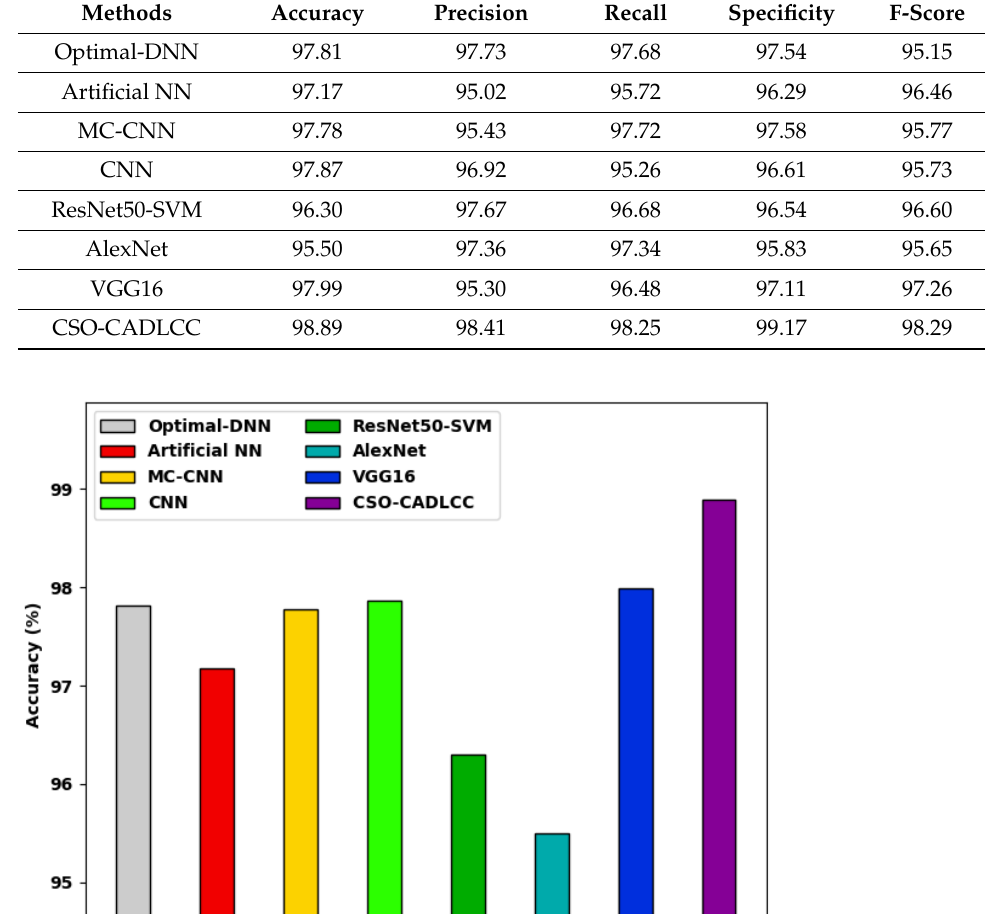
Figure 8. Accuracy analysis of the CSO-CADLCC technique with recent algorithms.